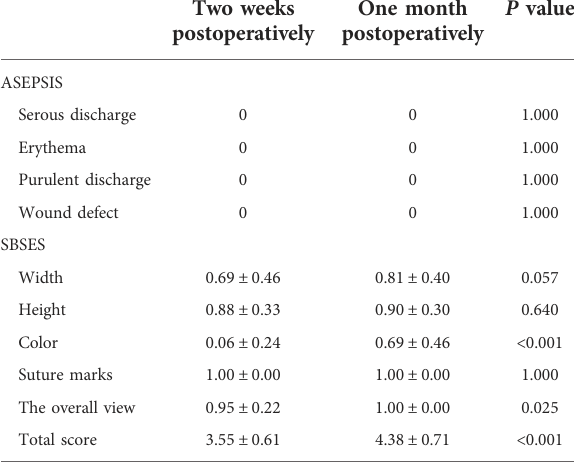
TABLE 4 The score results of the ASEPSIS and